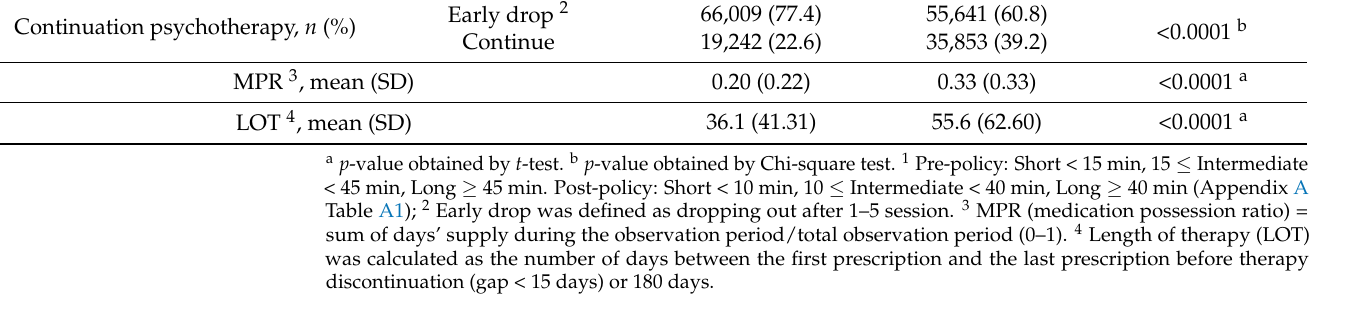
Table 3. Mean MPR (medication possession ratio) and persistence of patients with